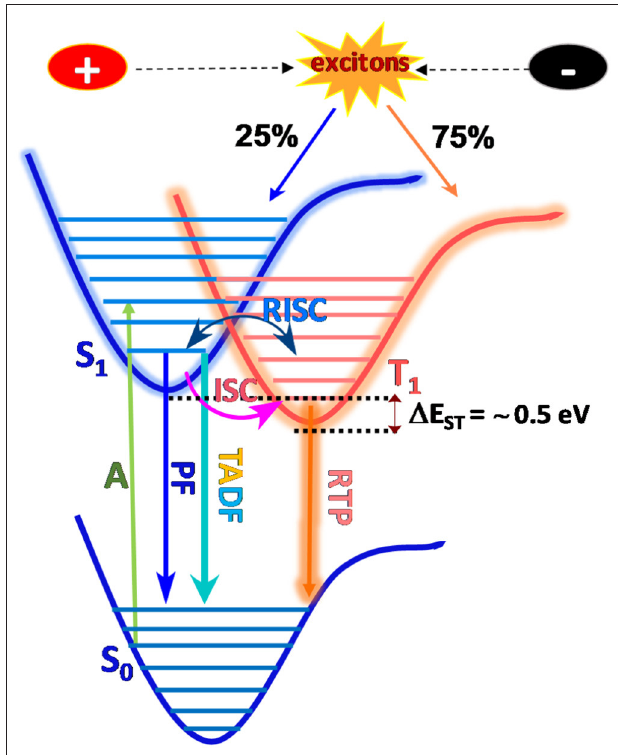
FIGURE 1 | Mechanistic view of Jablonski diagram: multiple emission originates through the radiative decay of the energetically excited state (S 1 ) to the ground state (S 0 ) and is denoted as prompt fluorescence (PF), TADF, and RTP through the ISC and RISC process.